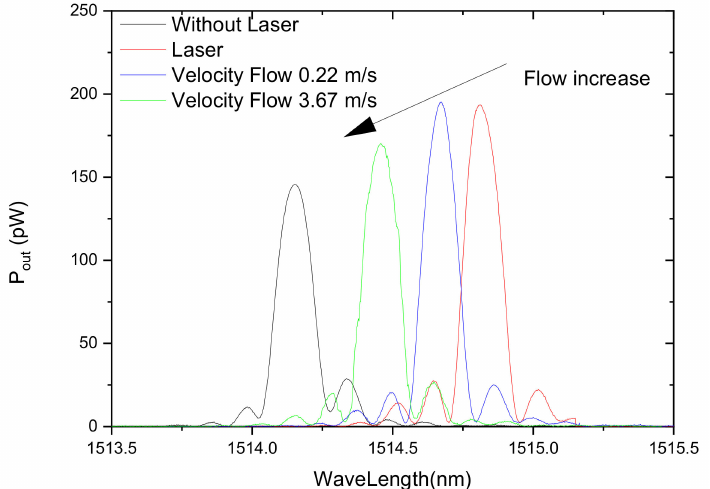
Figure 23. Experimental setup with detail of the sensing head. Reprinted with permission from [161]. © 2021 The Optical Society.